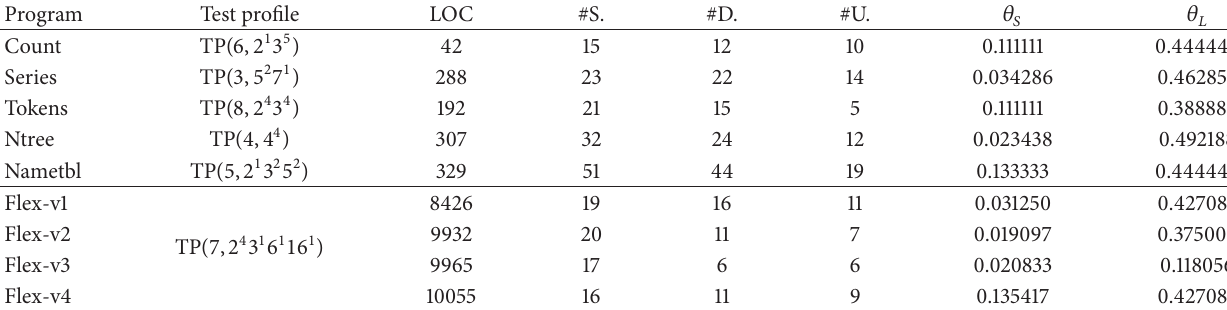
Table 3: The detailed information about 6 programs with 9